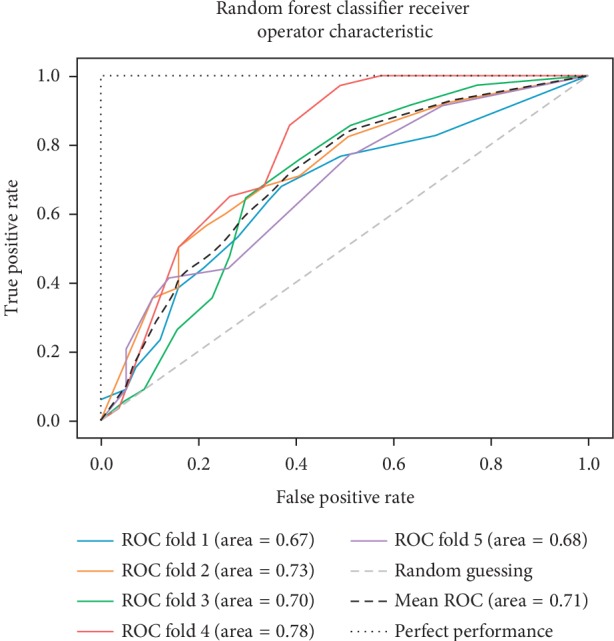
ROC curve for RF.